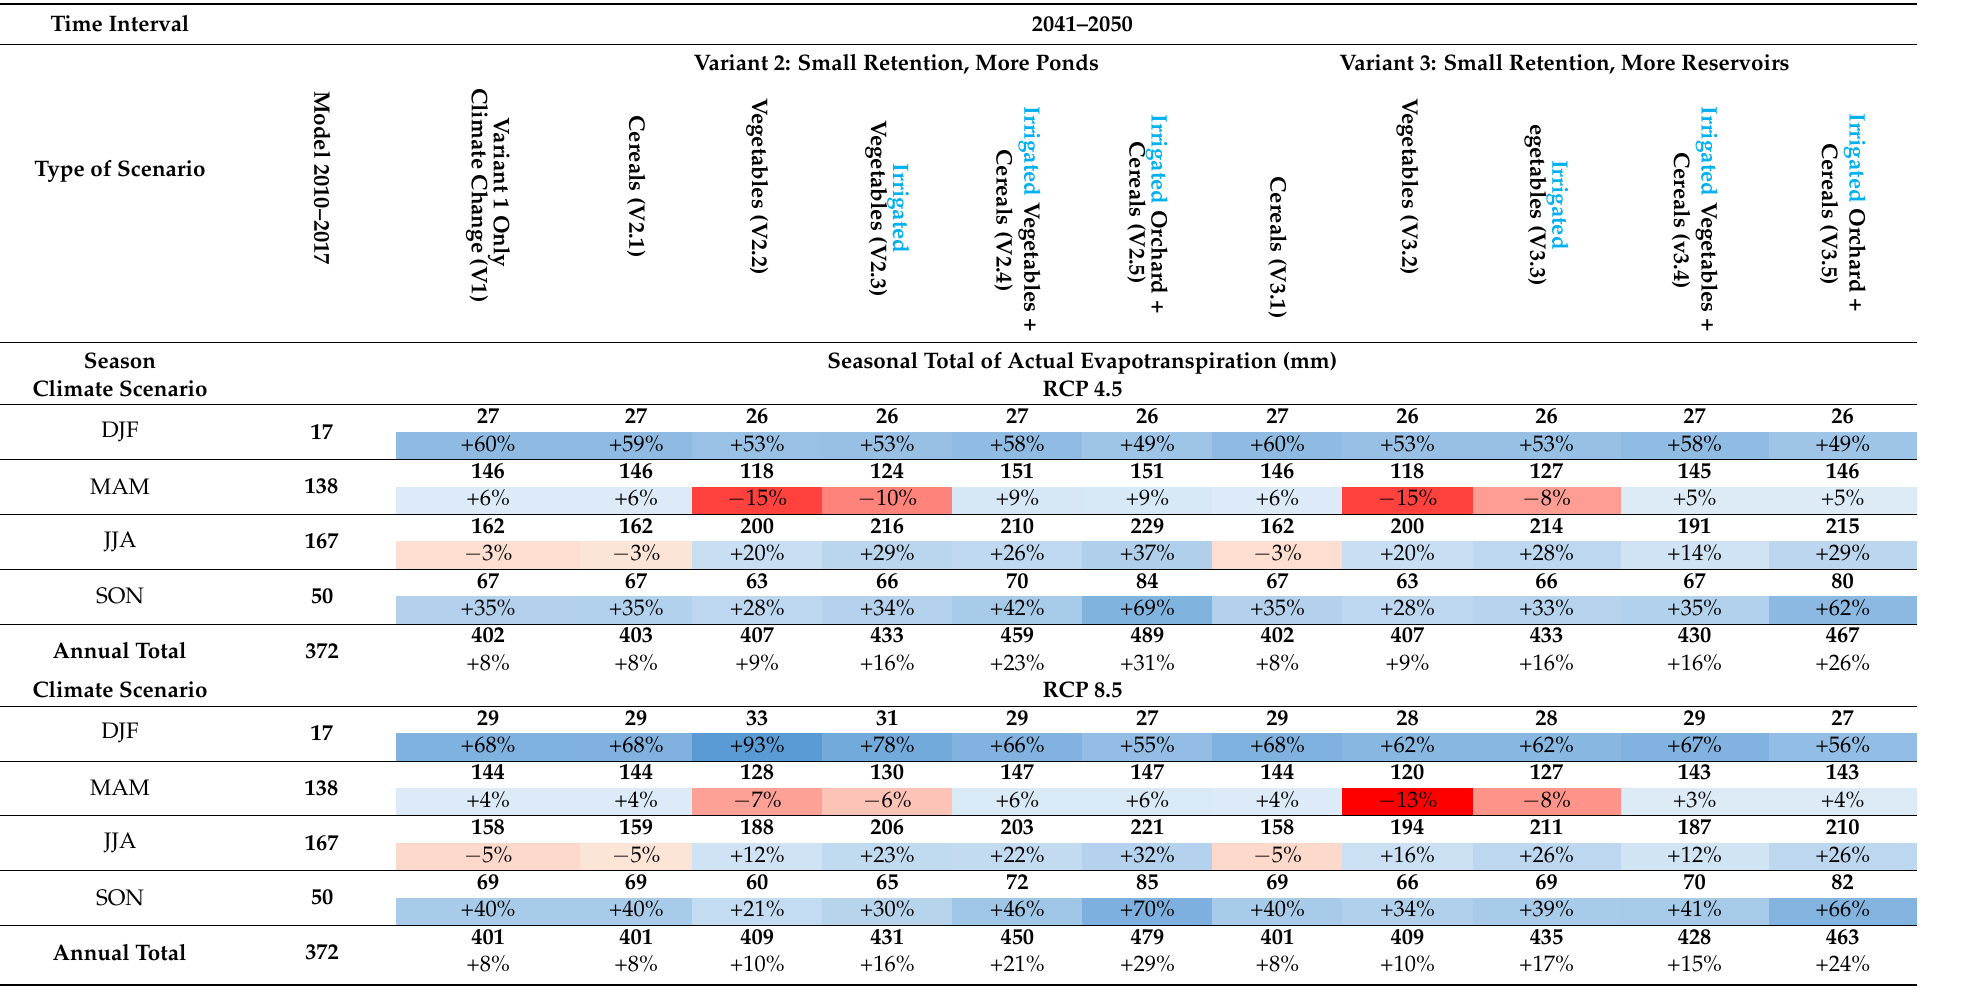
Table 7. Average actual evapotranspiration in the Bystra catchment for DJF (December, January, February, etc.), MAM, JJA and SON in 2041–2050 under various scenarios (SWAT model, V1, V2.1-V2.5 and V3.1–V3.5) for climate scenarios RCP 4.5 and RCP 8.5. Numbers in red (decreases) or blue (increasea) refer to a percentage change in the water content in soil (bold numbers) (author’s own